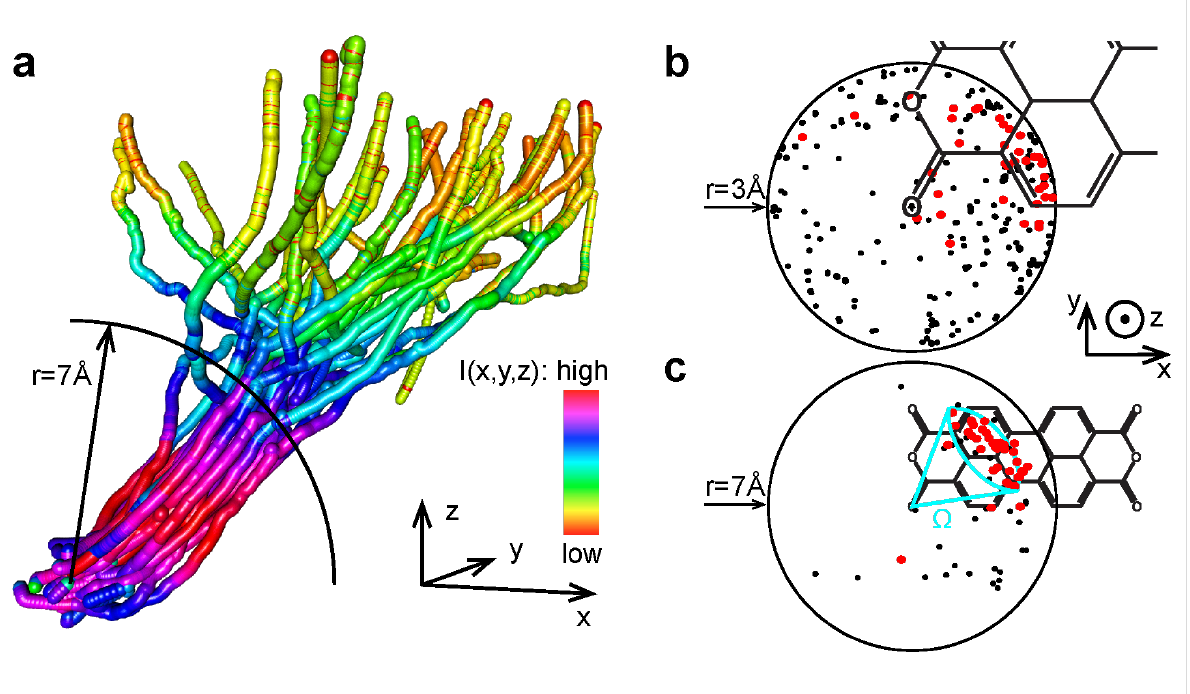
Figure 3: a) A perspective view on a set of 34 3-D manipulation trajectories that resulted in the removal of PTCDA molecules from the monolayer. In order to facilitate plotting, the density of recorded data was reduced by a factor of 100 to a sampling frequency of 10 Hz. Each point of the trajectory is plotted as a sphere with a radius of 0.2 Å, corresponding to the amplitude of the oscillations of the AFM/STM tip. The colour of the sphere reflects the value of I ( x , y , z ) measured at the given point of the manipulation trajectory. The black circle shows the boundary of the sphere from Figure 3c. For a more detailed view of the displayed 3D trajectories download the 3D animation or the interactive 3D model from Supporting Information. b,c) Full statistics of manipulation trajectories (including unsuccessful ones) (top view). The circle marks the boundary of a sphere with the radius 3 Å (b)